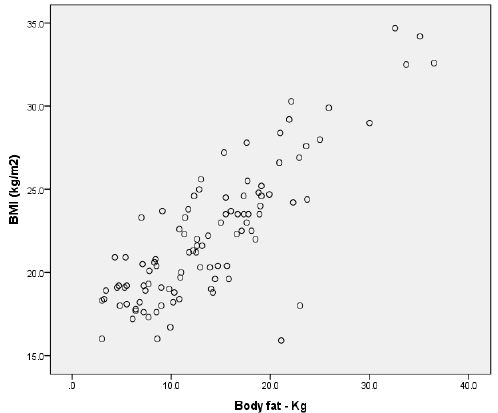
Figure 11. Correlation between BMI and body fat per group.